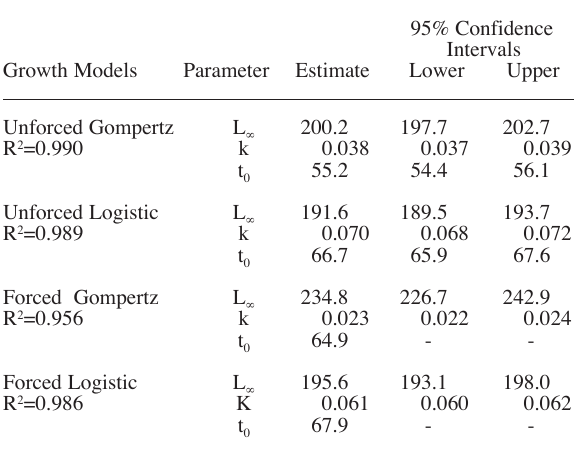
ABLE 3. – Parameters of Gompertz and Logistic curves fitted to length at age with upper and lower 95% confidence intervals. L asymptotic standard length (mm), k=growth coefficient, t tion point (in days of age). Parameters obtained with pooled length at age data from larvae-postlarvae and juveniles-pre-recruits caught in 2000 in Divisions VIIIc and IXa